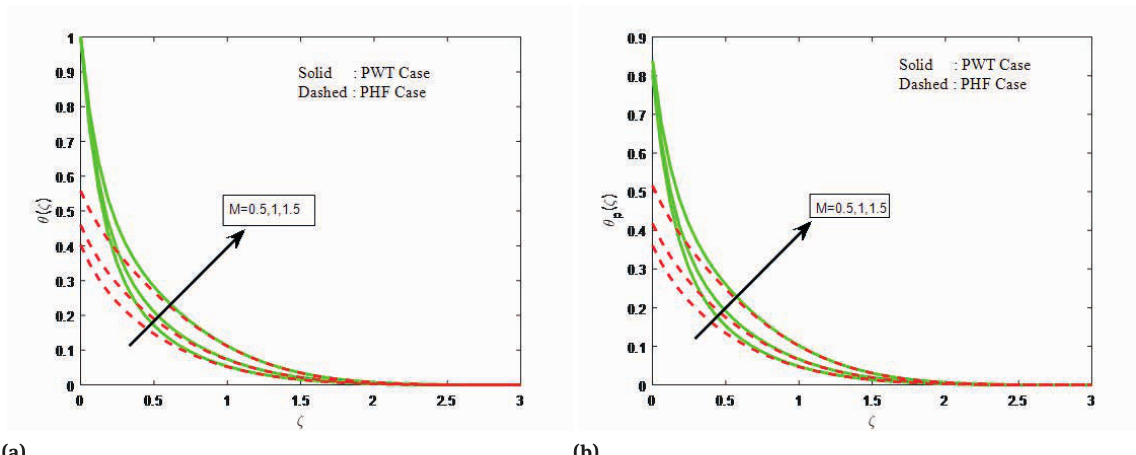
Fig. 7: a,b) Temperature profiles with varying thermal relaxation time ( γ